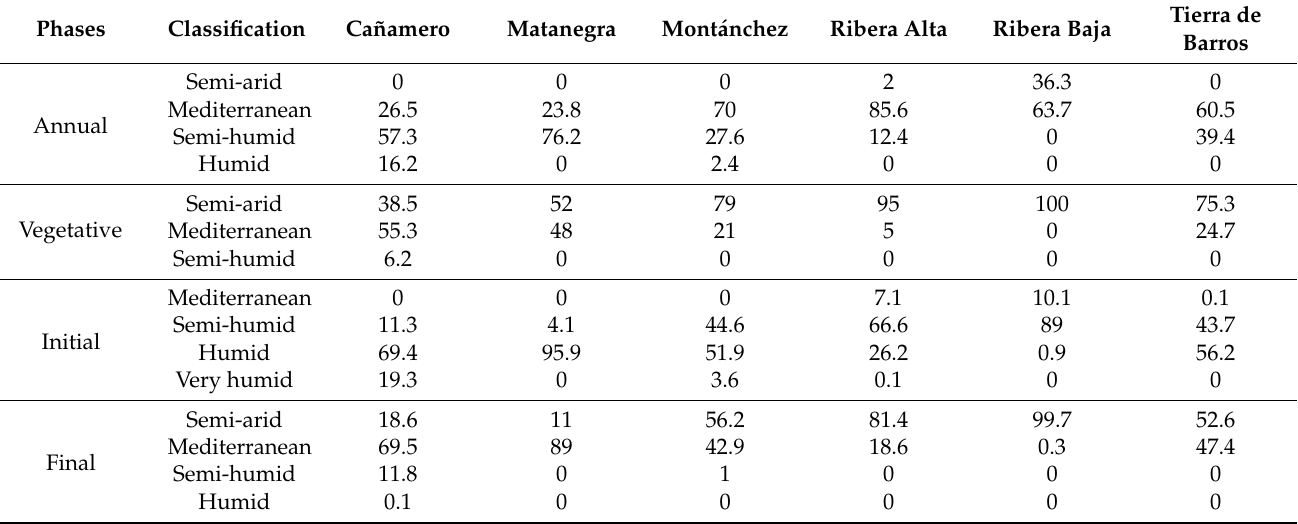
Table 5. Spatial classification of the subzones of the Ribera del Guadiana Protected Denomination of Origin (%) according to the I DM for the vine phases